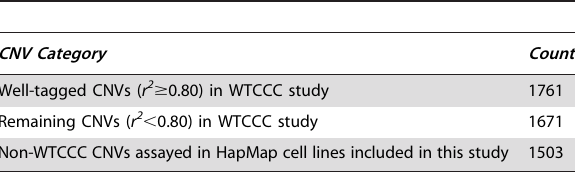
Table 1. CNV categories that were investigated for role in transcriptional